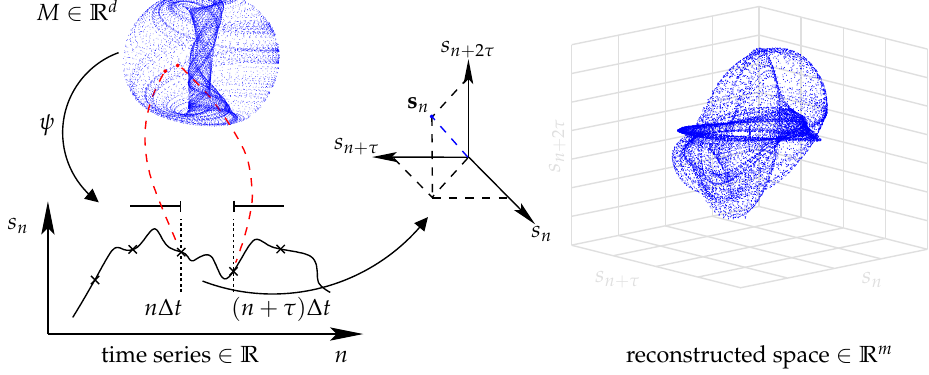
Figure 3. State space reconstruction general